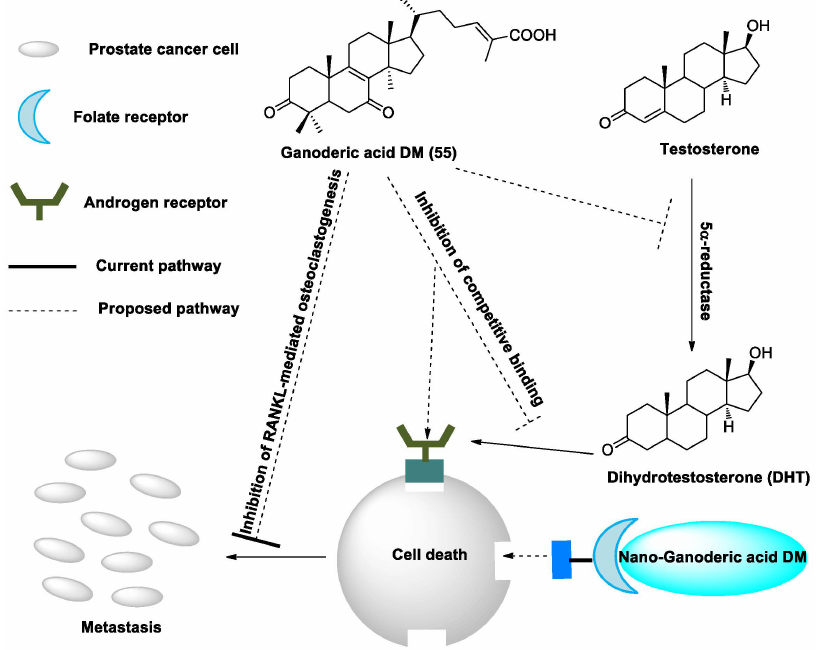
Figure 3. Suggested mechanisms by which ganoderic acid DM (GA-DM) may inhibit prostate cancer cell proliferation and metastasis.